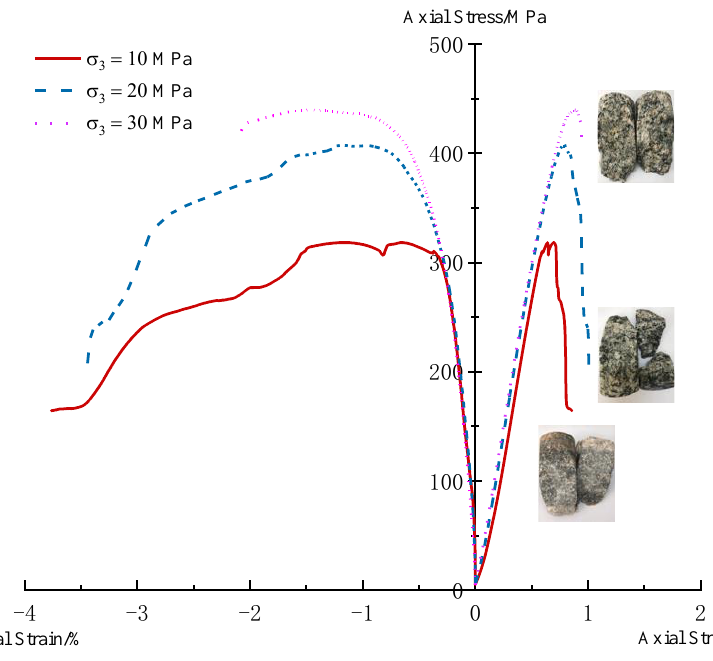
Figure 2. Stress – strain curve obtained from the triaxial test. Figure 2. Stress–strain curve obtained from the triaxial